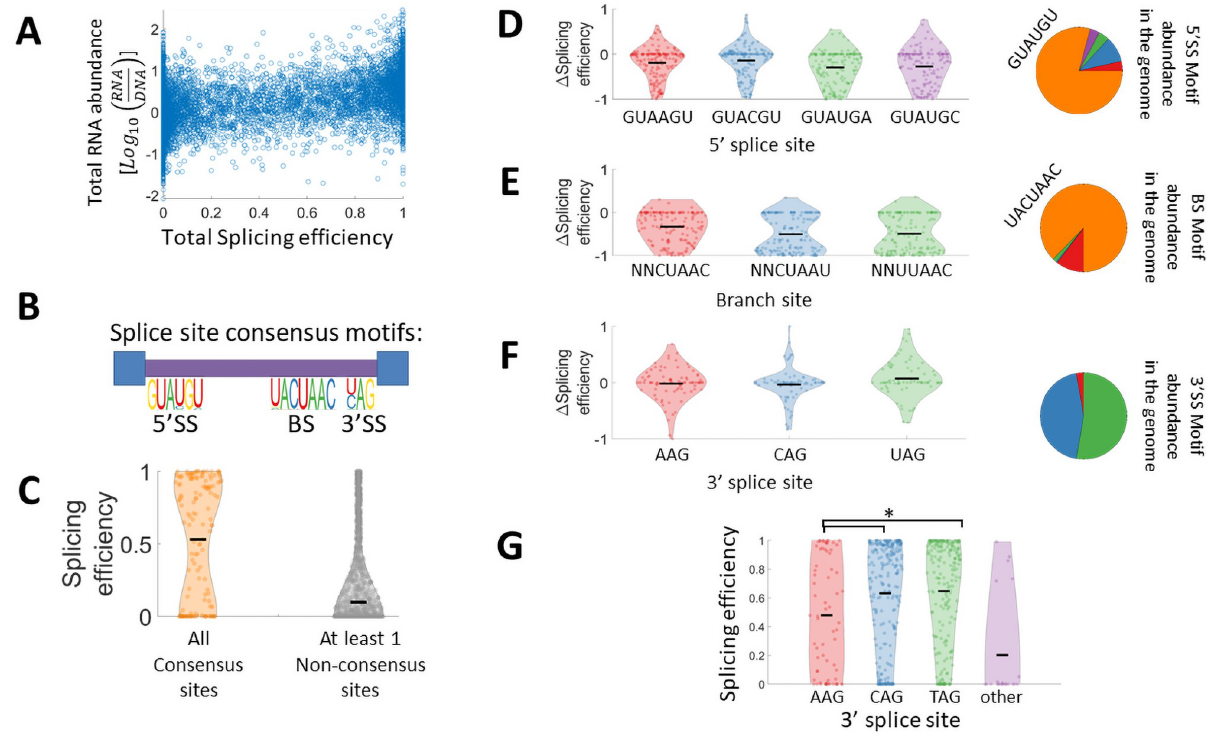
Fig 3. A set of combinatorially designed synthetic introns elucidate splice sites’ variants contribution to splicing efficiency. A. Scatter plot of the total RNA abundance and total splicing efficiency shows a significant positive correlation between RNA level and splicing efficiency (Pearson r = 0.47 p-value < 10 − 100 ). RNA abundance is defined as the log ratio between the RNA read frequency and the DNA read frequency per variant. B. Splice site motifs for S . cerevisiae introns as determined by their frequency in S . cerevisiae natural introns, one can notice a dominant consensus sequence for the 5’SS and BS, and two consensus sequences for the 3’SS. C. Distribution of splicing efficiency for synthetic intron variants with consensus splice sites at all 3 sites (orange), is significantly higher than splicing efficiency distribution for variants with at least one non-consensus splice site (grey) (two sample t-test, p-value < 10 − 80 ). Black horizontal line represents mean splicing efficiency. D-F. Effect of non-consensus splice site sequences on splicing efficiency. Violin plots represent the distribution of the difference in splicing efficiency between a variant with a single non-consensus splice site, to a corresponding consensus sites variant which is identical in any other parameter. For the 3’SS since there are two consensus sequences, AAG variants were compared against the average of the two consensus variants, and CAG/UAG variants were compared against the other consensus variant. Pie charts show the relative abundance of each splice site in S . cerevisiae genome (orange slice represents the consensus site, and other colors correspond to the colors in the violin plots). In the case of the BS, NNCUAAC non-consensus variants represent all sequences that fit this template but different from the consensus sequence UACUAAC. Note that for the BS pie chart in (E) the blue portion representing NNCUAAU variants is too small to be visible. G. Splicing efficiency distribution only for the natural introns set considering introns with consensus 5’SS and BS, and binned according to different 3’SS (AAG introns’ splicing efficiency are significantly lower than CAG/TAG introns, t-test p-value <